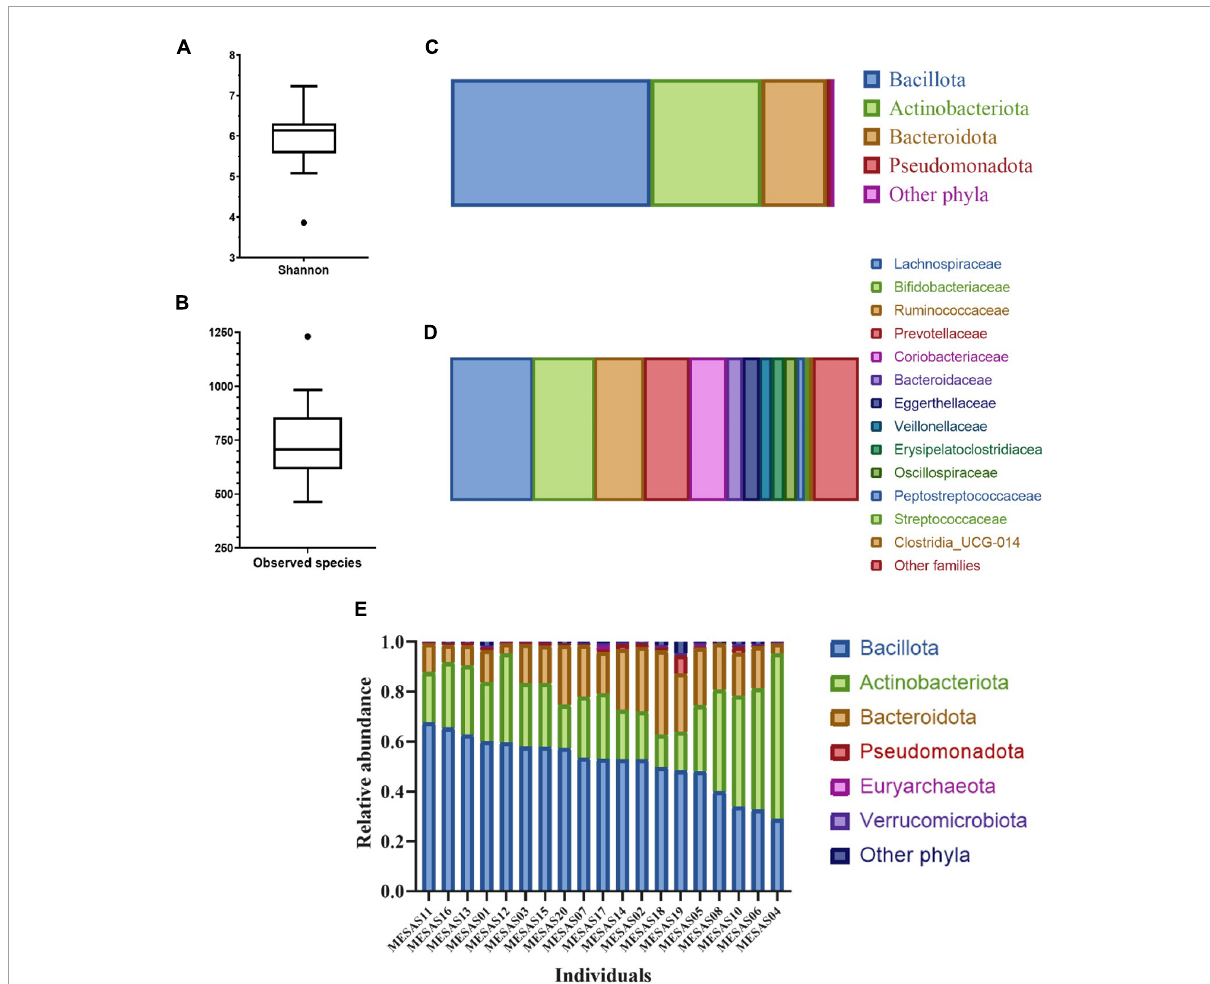
FIGURE1 Diversity indices and GM relative abundance composition. Box plot of Shannon index (A) and Observed species index (B) . GM profile at phylum (C) and family level (D) ; only taxa showing mean relative abundances higher than 1% are shown. GM main phyla relative abundance distribution in the sample of study disaggregated by individual (E)